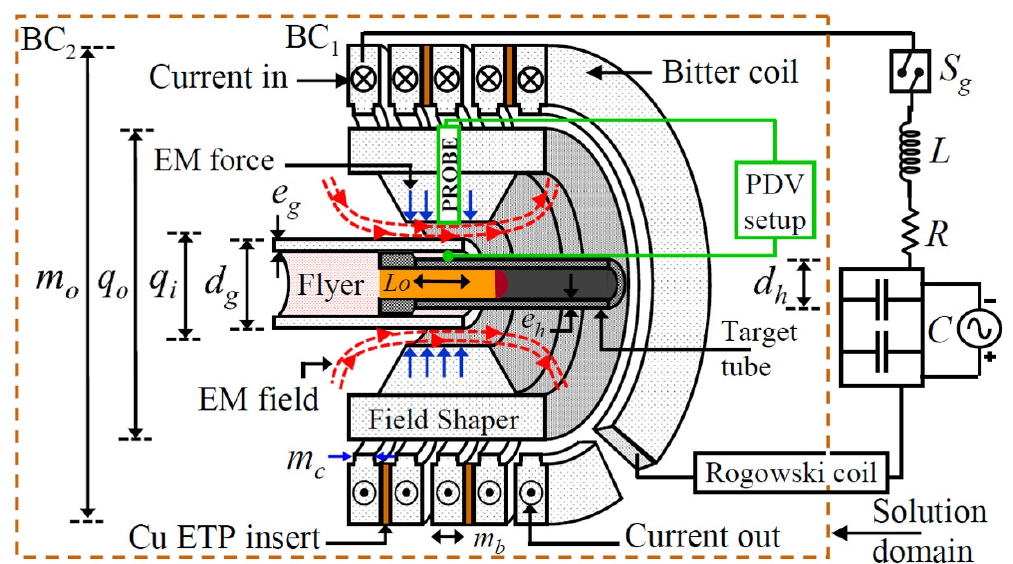
Figure 2. Schematic representation of the coil-tube assembly and solution domain. Table 1. Details of discharge circuit elements and energy